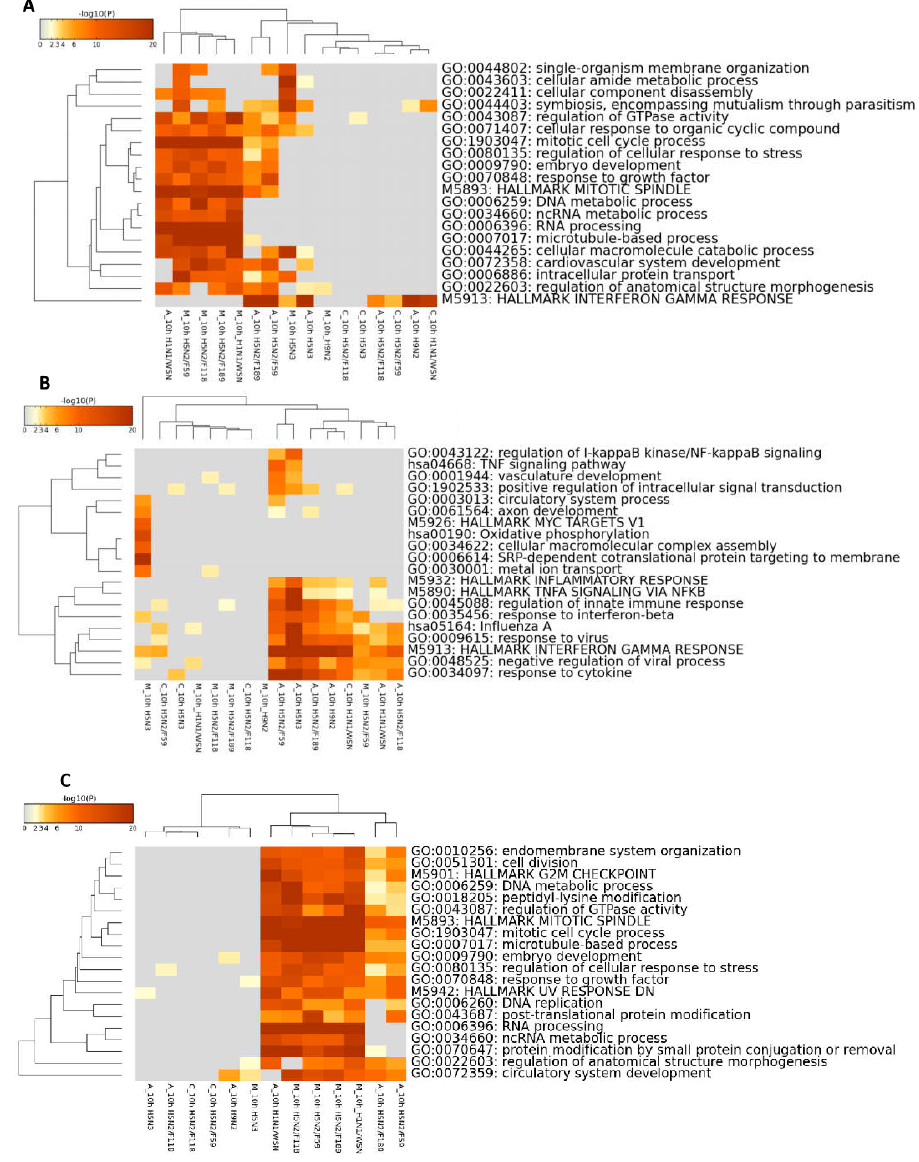
Figure 2. Functional annotation of the DEGs in A549, CEF and MDCK cell lines during influenza A virus (IAV) infections at 10 hpi. ( A ) Functional annotation of both up-and down-regulated genes